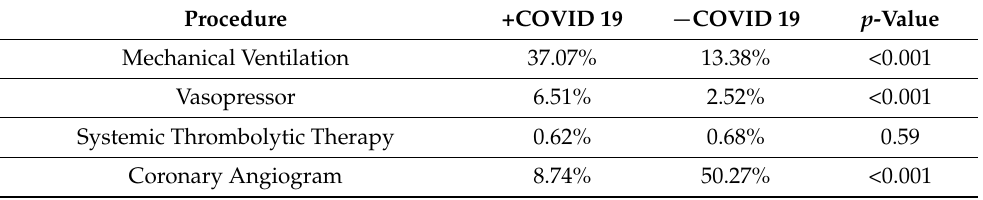
Table 5. Procedures and Cardiac Complications Among NSTEMI Patients Based On COVID-19